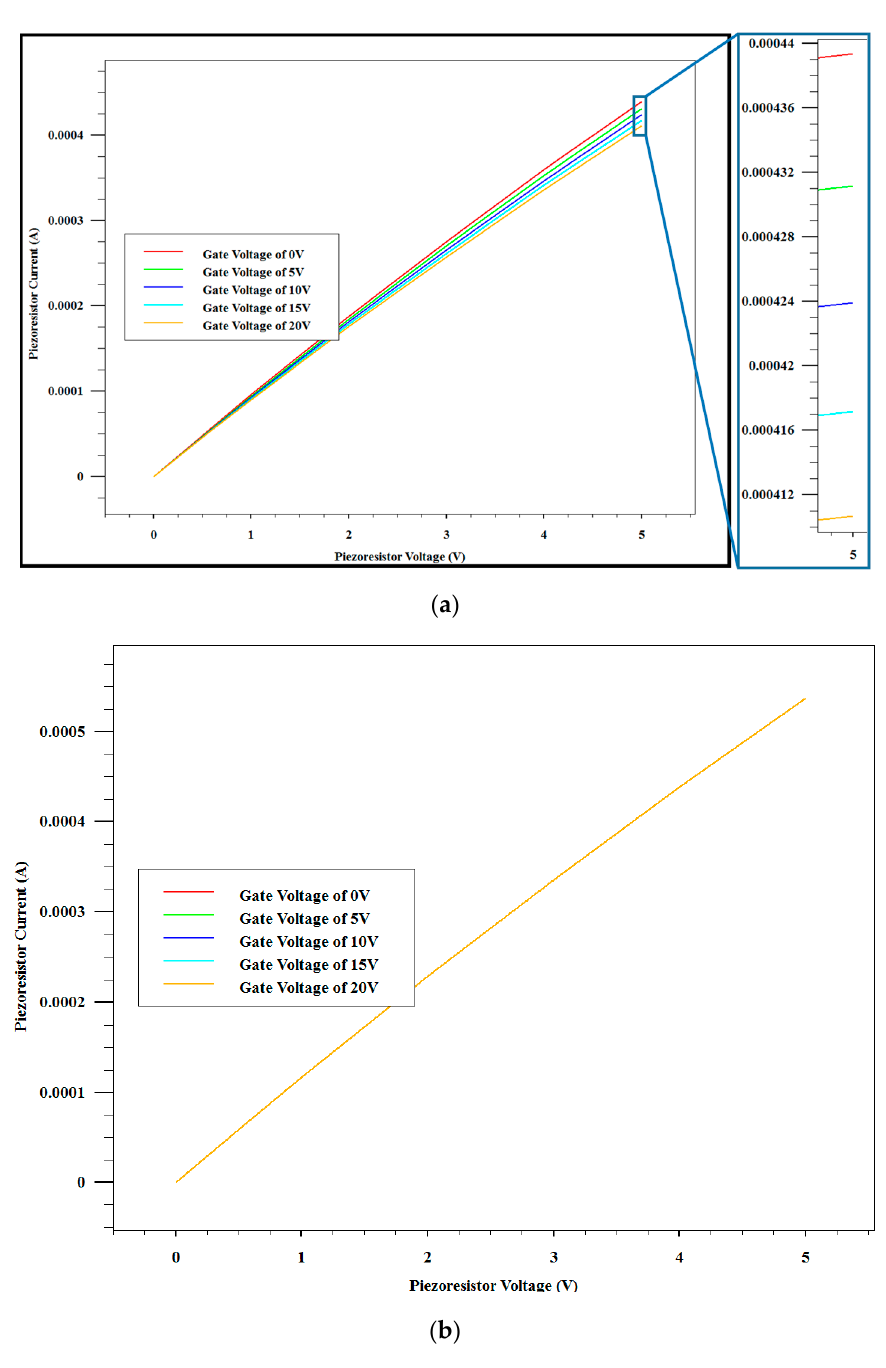
Figure 5. Simulated I-V characteristics of pressure sensors without ( a ) and with ( b ) a shield layer at different gate voltages.